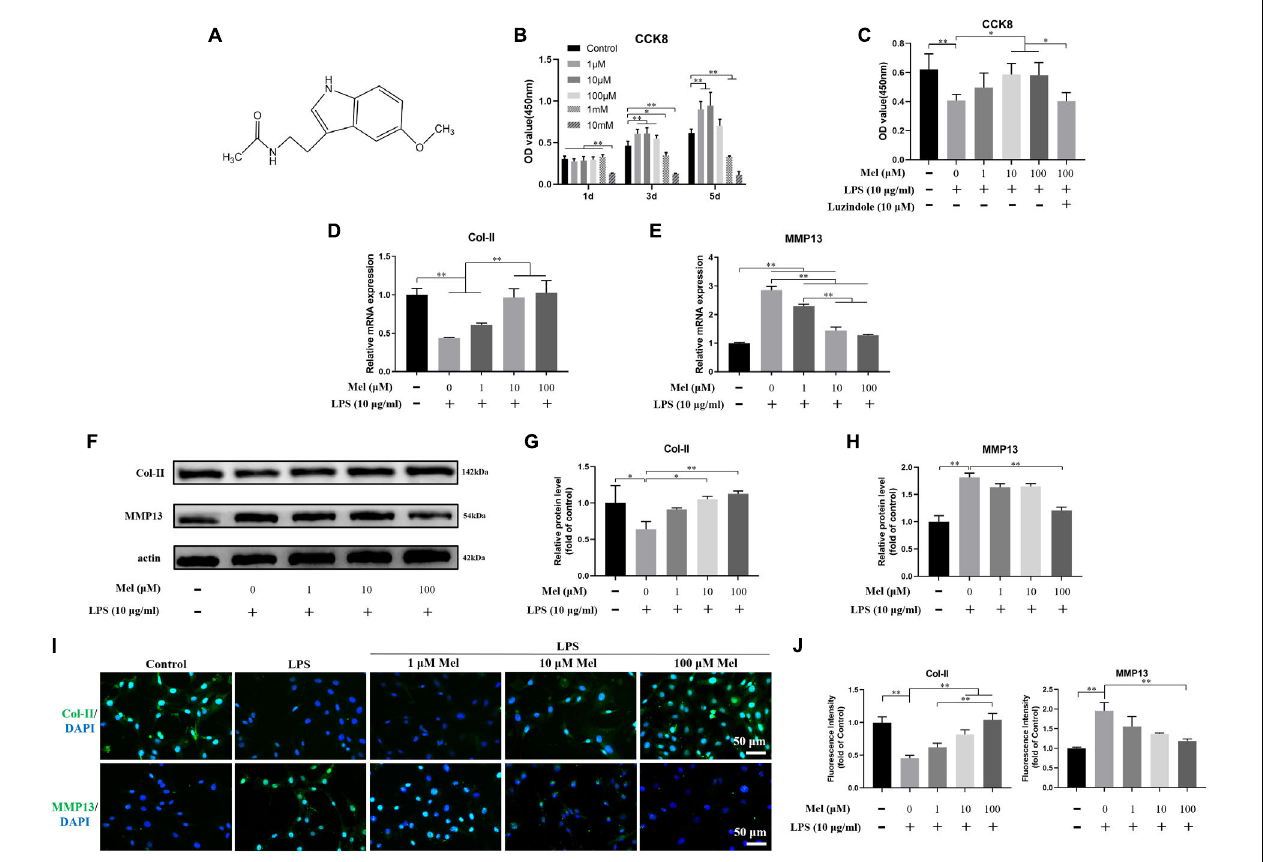
FIGURE 5 | Melatonin (Mel) alleviated the degeneration of endplate cartilaginous cells (EPCs). (A) Molecular formula of Mel. (B) Optical density (OD) values (450 nm) of cell counting kit-8 (CCK-8) assay on EPCs under 1 µ M, 10 µ M, 100 µ M, 1 mM, and 10 mM of Mel treatment at 1, 3, and 5 days. (C) OD values (450 nm) of CCK-8 assay on EPCs under lipopolysaccharide (LPS), Mel, and Luzindole treatment at 3 days. (D,E) qRT-PCR analysis of the relative mRNA expression of type II collagen (Col-II) (D) and matrix metalloproteinase-13 (MMP13) (E) under LPS and Mel treatment. (F) Western blotting for proteins of Col-II and MMP13 under LPS and Mel treatment. (G,H) Quantitation of relative protein level of Col-II and MMP13. (I) Immunofluorescence staining of Col-II and MMP13 under LPS and Mel treatment. (J) Quantitation of fluorescence intensity of Col-II and MMP13 ( ∗ P < 0.05, ∗∗ P <